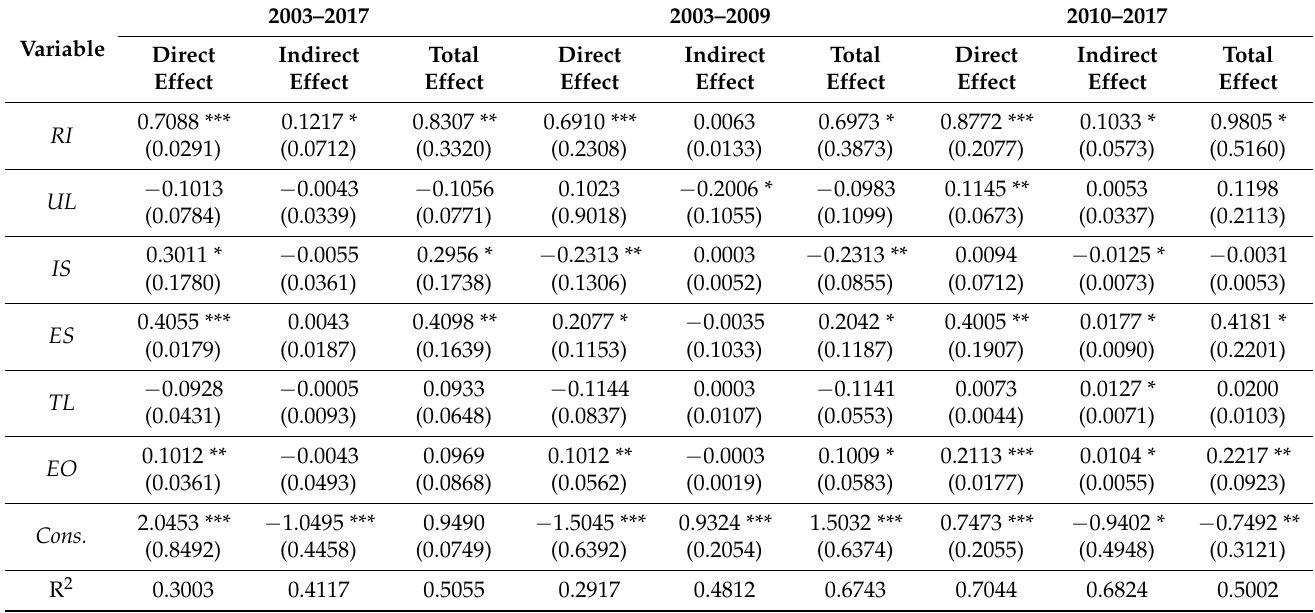
Table 4. Decomposition of UGDE effects of regional